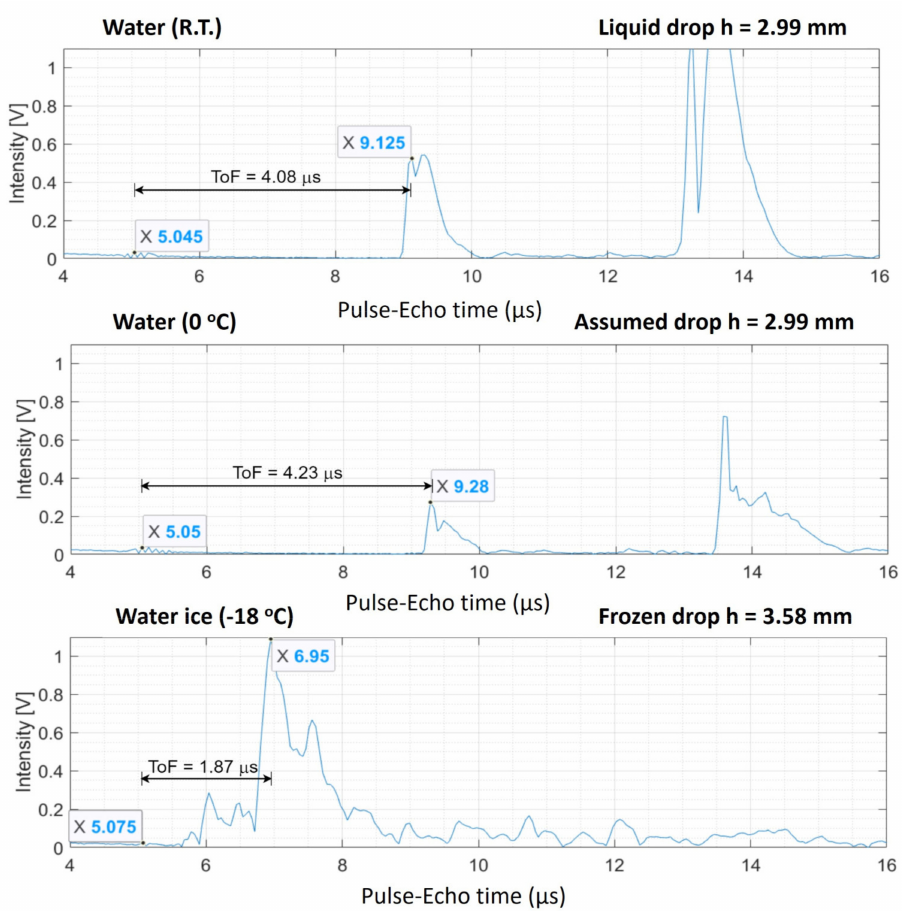
Figure 5. Typical set of A-scans for compact drop experiment. For three different temperature values, the ToF between the first arriving longitudinal reflected wave fronts from the top of the drop surface was subtracted and displayed in the respective graphs. This value was used to calculate the ultrasonic velocity in the drops by dividing the drop